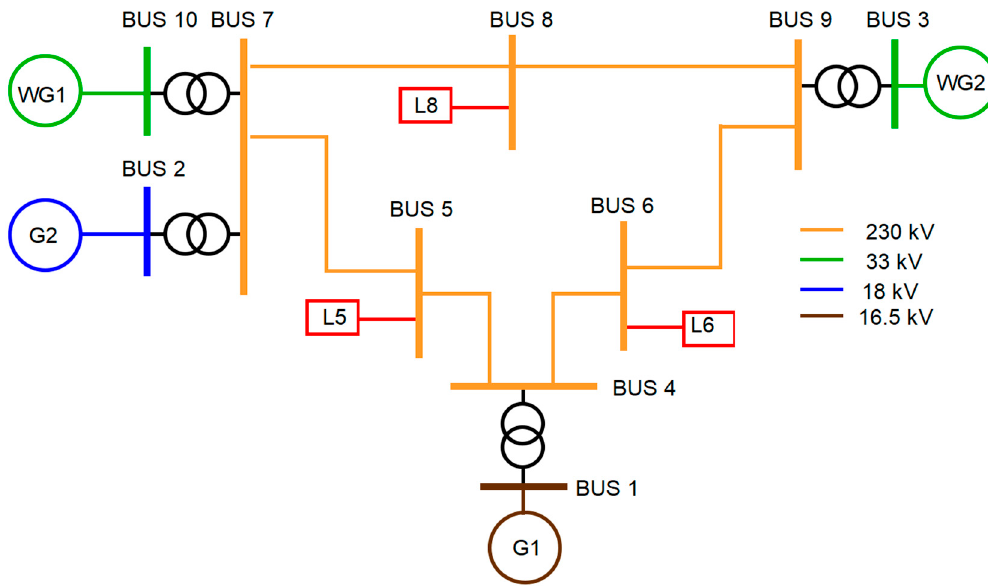
Figure 6. Modified IEEE 9 bus model with a 52% wind generator share.